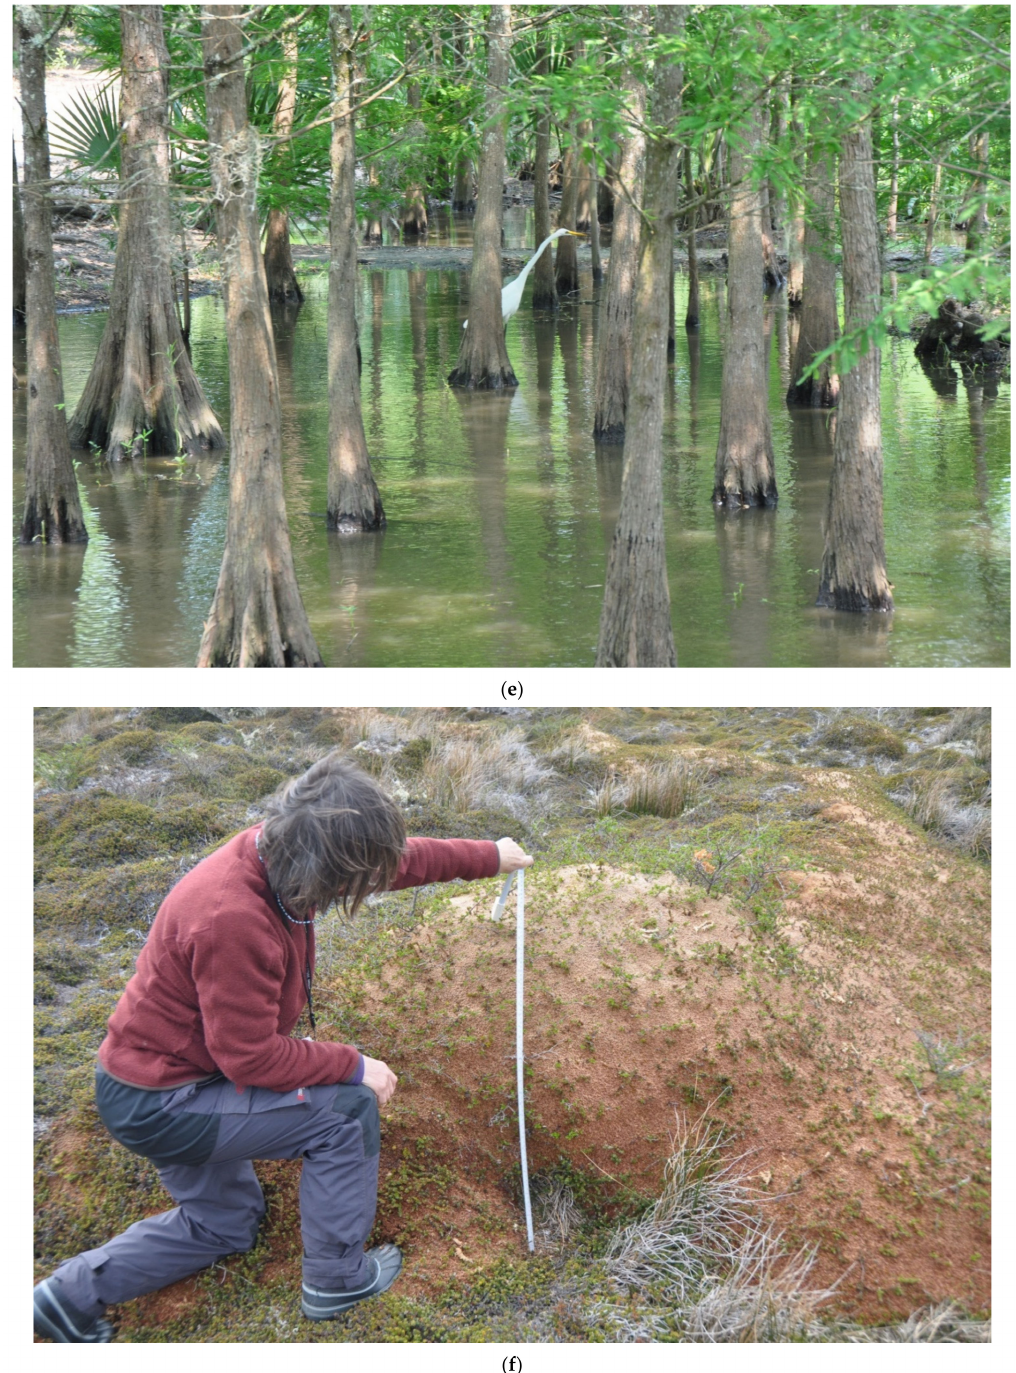
Figure 10. Selection of the extreme diversity of wetland types and species: ( a ) muskeg in Alaska showing “drunken” stand of Black spruce ( Picea mariana ) on peat and permafrost; ( b ) the distinctive microrelief patterning of hummock and pools in “hollows” of blanket bog and the extraordinary height of stands of Phragmites in the Perishan wetland of Iran; ( c ) examples of carnivorous plants— ( 1 ) sundew and ( 2 ) pitcher plants—adapted to source nutrients from insects to supplement nutrient deficiencies in the peaty substrate, in both temperate and tropical climates ( 3 ) Human bodies uniquely preserved in the acidic waterlogged peat provide evidence of diet, associated environmental con- ditions as well as cause of death; ( d ) fringing mangroves in coastal Louisiana; ( e ) cypress swamp ( Taxodium distichum ) in Florida; ( f ) Hummocks of Spagnum magellanicum in Tierra del Fuego bog. Source: Edward